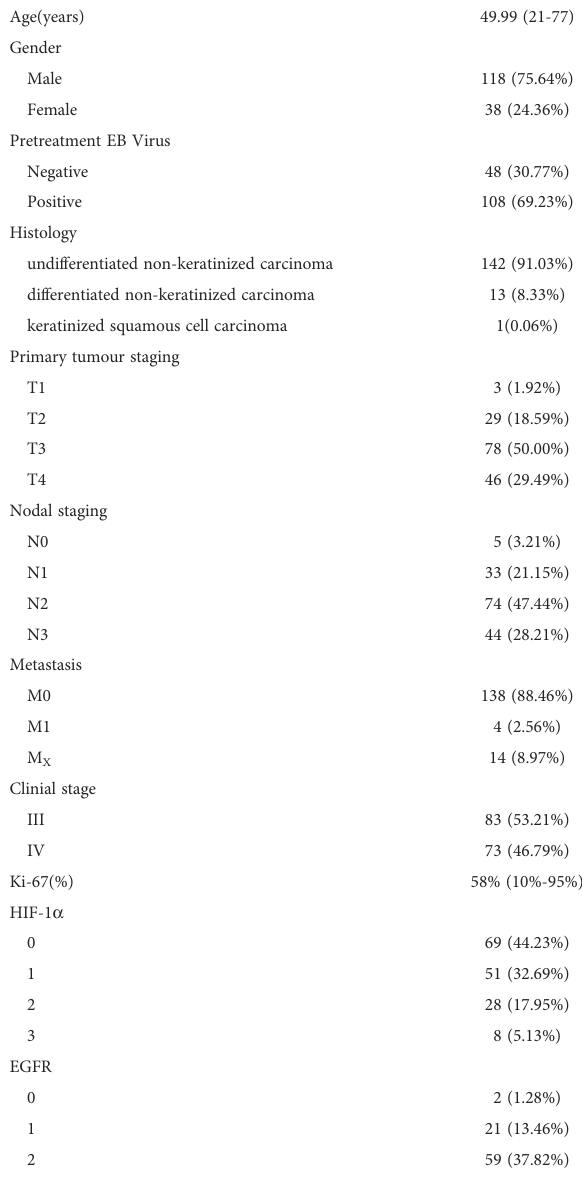
TABLE 1 Characteristics of 156 patients with